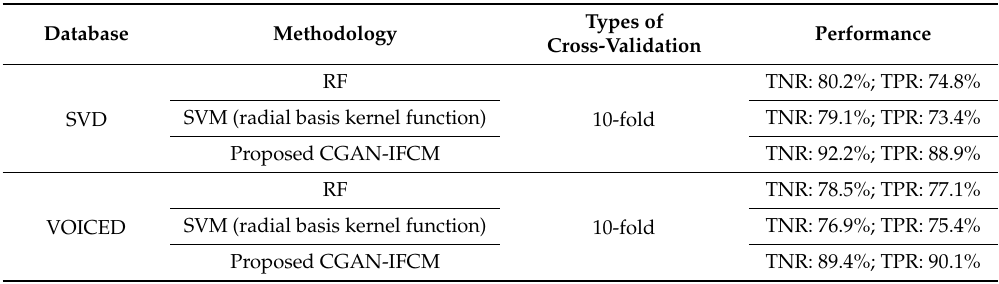
Table 10. Performance comparison between CGAN-IFCM and two typical algorithms (random forest and support vector machine) for a multi-class detection model of voice disorder detection.